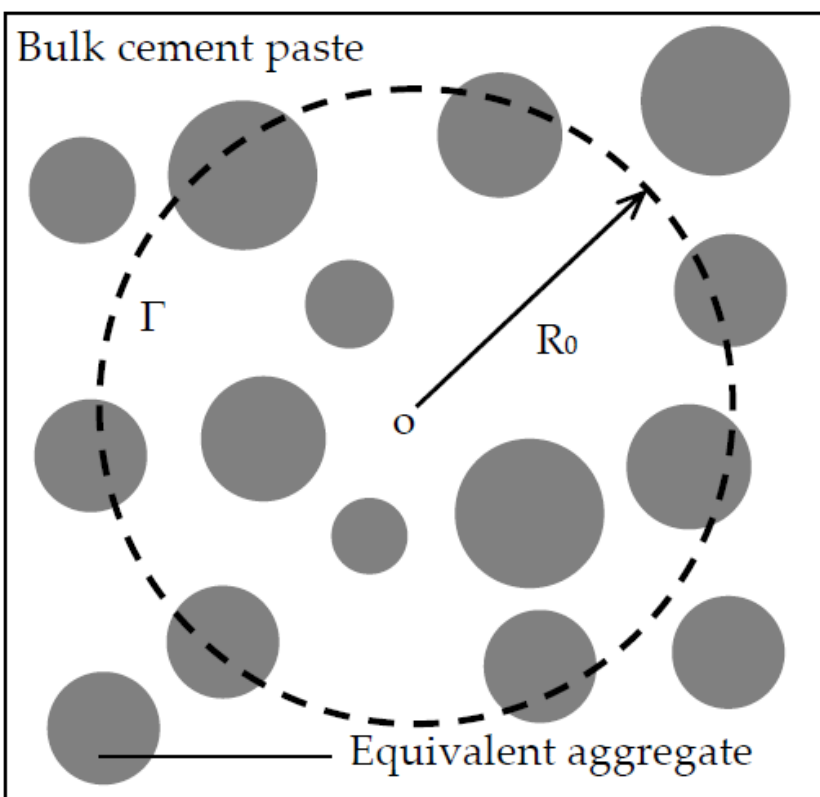
Figure 5. Two-phase concrete composed of bulk cement paste and equivalent aggregates.